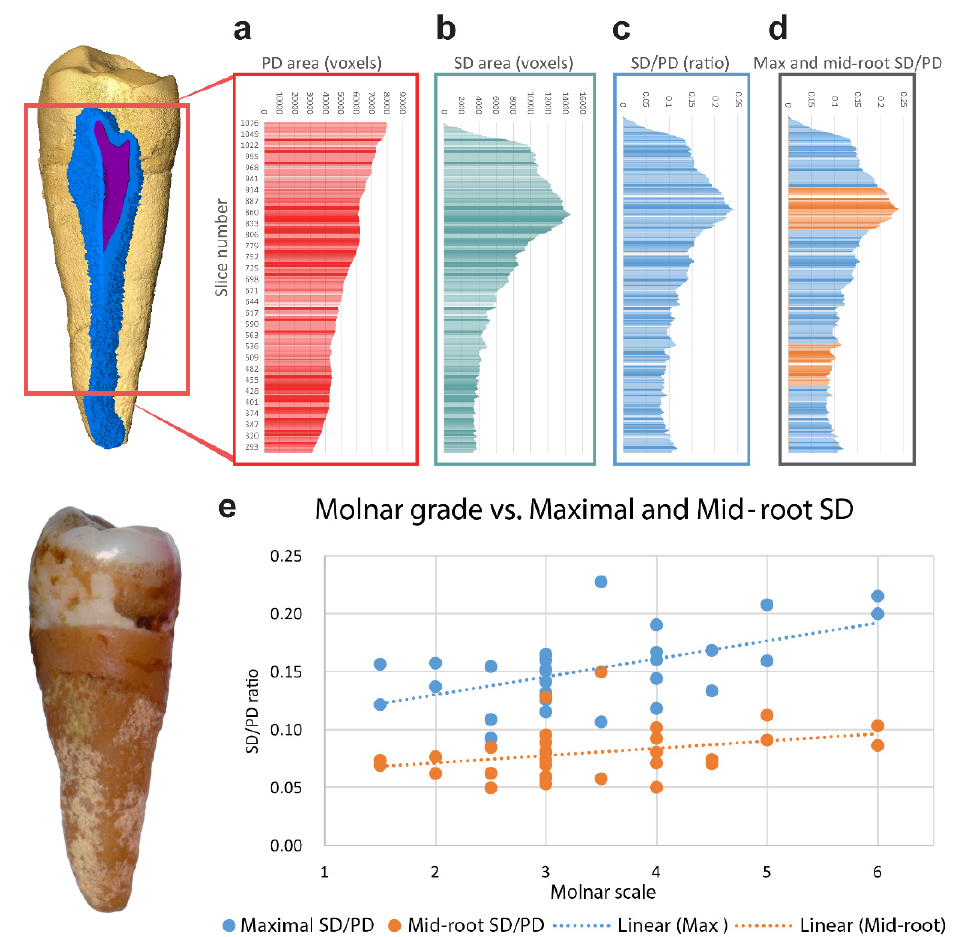
Figure 1. SD and PD evaluation of horizontal slices. Representative image of 30 teeth examined, isosurface of a tooth with a three-dimensional representation of the SD layer (blue) on top of the pulp (purple) and original tooth below. ( a ) PD area in voxels (red) for each slice from the first slice with SD to the bottom third of the tooth. ( b ) SD area (green) for each voxel slice. ( c ) SD/PD ratio (blue) for each slice. ( d ) Max and mid-root SD/PD ratios. There are 100 maximal (upper) and 100 mid-root slices (lower) demarcated in orange. ( e ) SD/PD values of maximal (blue) and mid-root (orange) measurements, partitioned by attrition levels ( r = 0.577 * and r = 0.331 accordingly, Spearman’s correlation) * p < 0.05, n = 30.